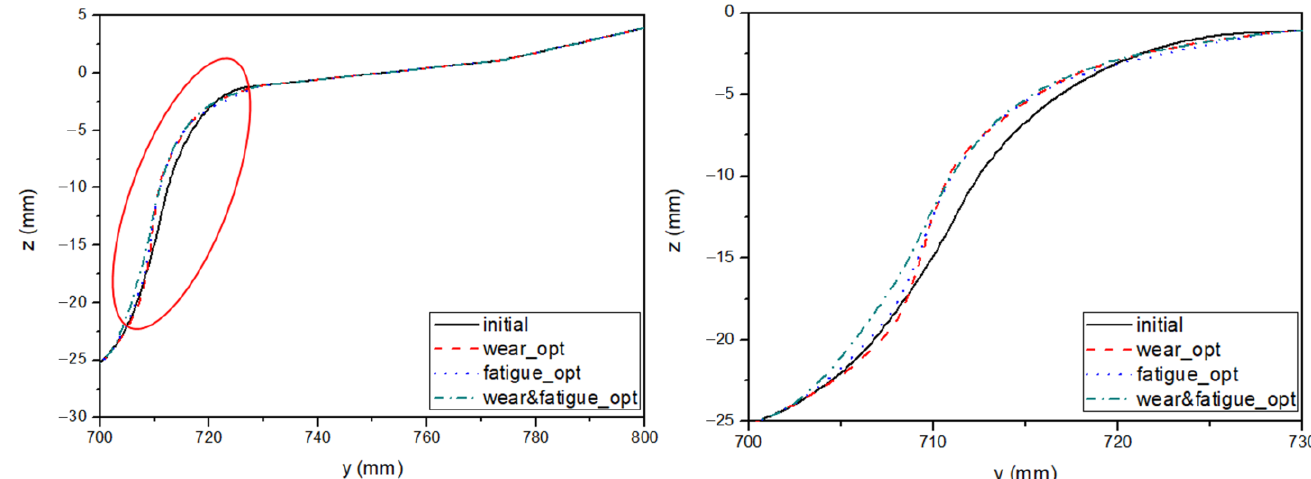
Figure 12. Comparison of wheel profiles ( Left : overall shapes, Right : detailed shapes).